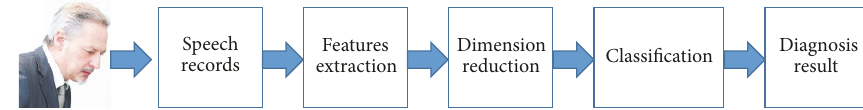
Figure 3: Workflow of the proposed method.